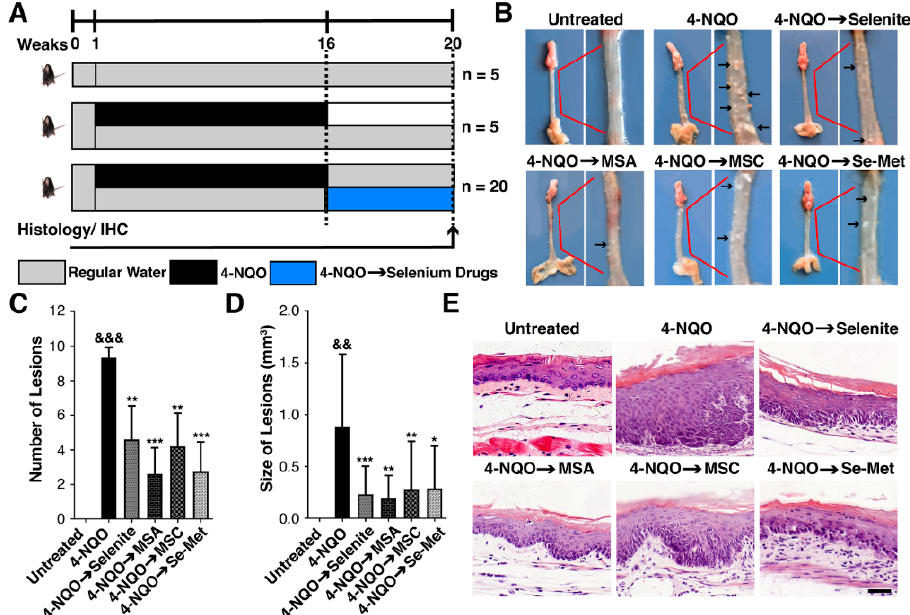
Figure 2. Selenium impedes ESCC lesions in the 4-NQO mice model. ( A ) Scheme for the treatment paradigm. C57BL/6 mice were randomized into six groups ( n = 5, per group) and fed with water or 4-NQO (100 µg/mL) in drinking water for 16 weeks, after which all mice were given deionized water until week 20. Selenite (0.05 mg/kg), MSA (0.05 mg/kg), MSC (0.1 mg/kg), Se-Met (0.1 mg/kg) were administered via intragastric intubation on Monday, Wednesday, Friday after 16 weeks of 4-NQO exposure for 4 weeks. (4-NQO → Se compounds; shaded in blue). The histopathological